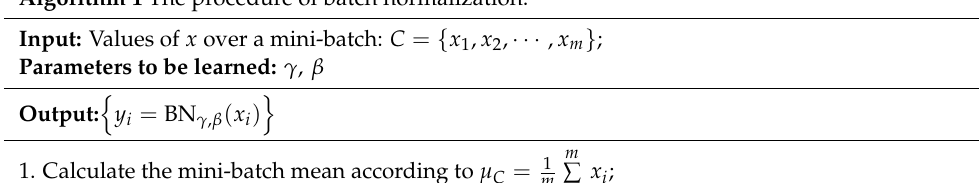
Algorithm 1. The procedure of batch normalization.